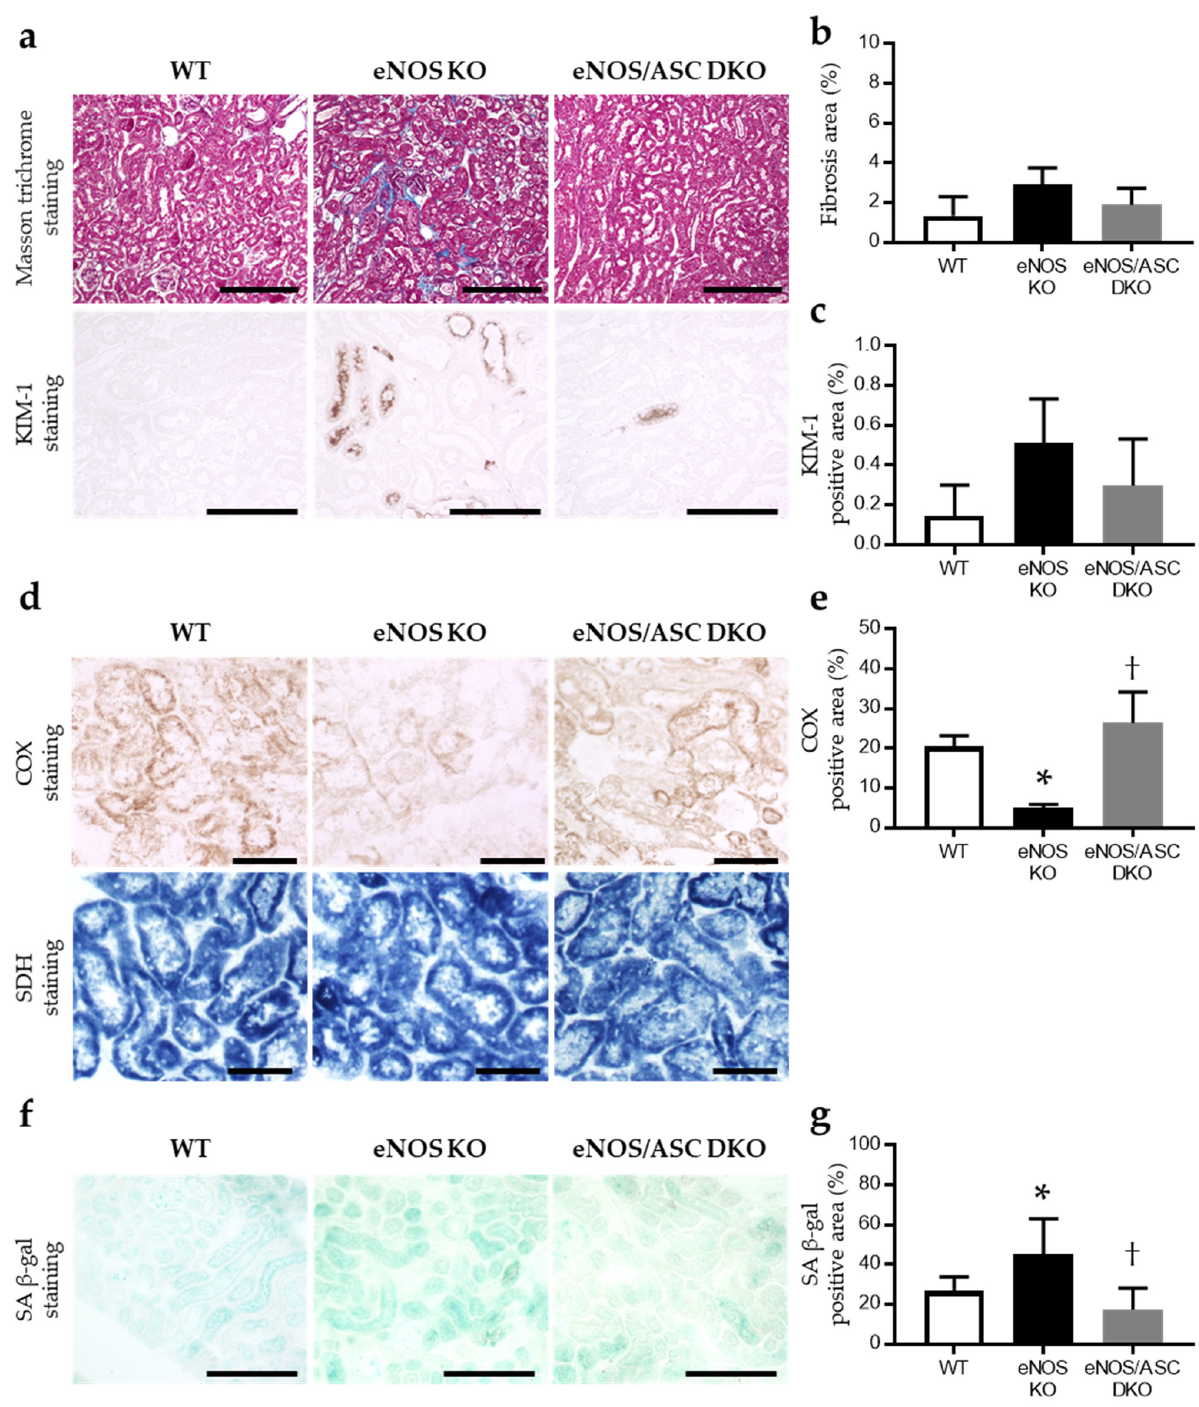
Figure 3. Aged-eNOS KO accelerated mitochondrial damage and cellular senescence but not eNOS/ASC DKO: ( a ) upper panel; Masson trichrome staining (bar = 250 μ m), lower panel; immunohistochemical staining for KIM-1 (bar = 100 μ m); ( b ) percentage of aniline blue-positive area in Masson trichrome staining; ( c ) percentage of KIM-1 positive area; ( d ) upper panel is COX activity staining (bar = 50 μ m); lower panel is SDH activity staining (bar = 50 μ m); ( e ) percentage of COX positive area. ( f ) SA β -gal activity staining. Bar = 250 μ m; ( g ) percentage of SA β -gal positive area. Data are expressed as means ± SD. WT, wild type ( n = 3–6); eNOS KO, eNOS KO mice ( n = 3–6); eNOS/ASC DKO, eNOS/ASC DKO mice ( n = 3–6); KIM-1, kidney injury molecule 1; COX, cytochrome c oxidase; SDH, succinate dehydrogenase; SA β -gal, senescence-associated beta-galactosidase. * p < 0.05 vs. WT, † < 0.05 vs. eNOS KO.